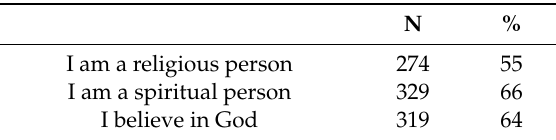
Table 11. Self-assessed religiosity.